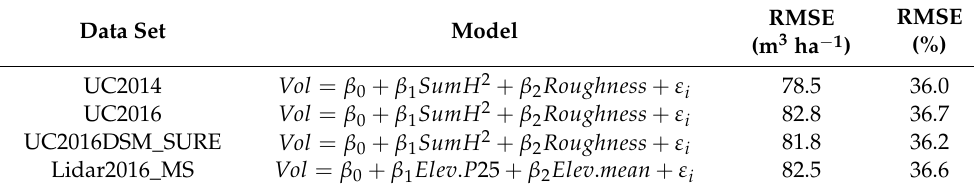
Table 3. Regression models of mean stem volume (see Section 3.5.1. above) used for each data set, with corresponding RMSEs (absolute and in percent of the surveyed mean). SumH 2 is the sum of squared heights for the local maxima; Roughness is the surface roughness of the CHM; Elev.P 25 is the 25th height percentile and Elev.mean is the mean